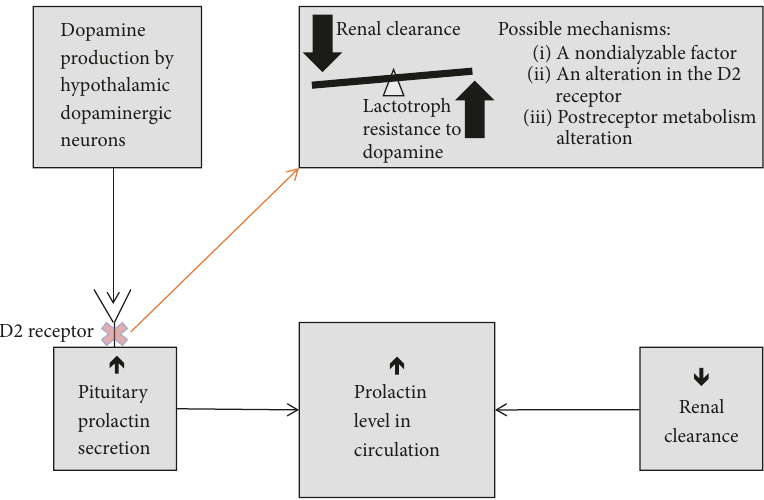
Figure 2: Concept to explain hyperprolactinemia in end-stage renal